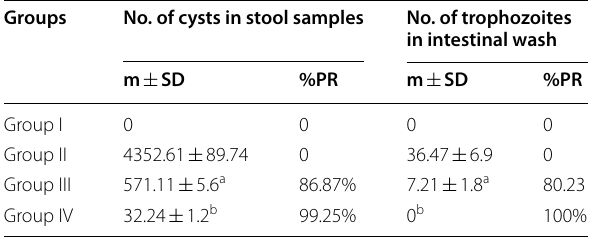
Table 5 parasitological examination of stool and intestinal wash samples